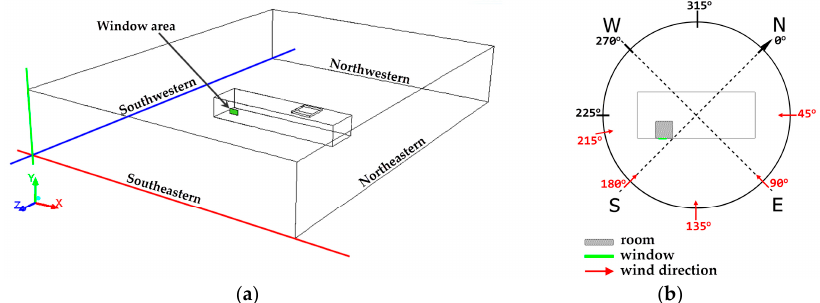
Figure 5 . Illustrations of: (a) orientation of computational domain, (b) top view of building and angle of wind direction. Table 1. Boundary conditions dependent on the incident angle.